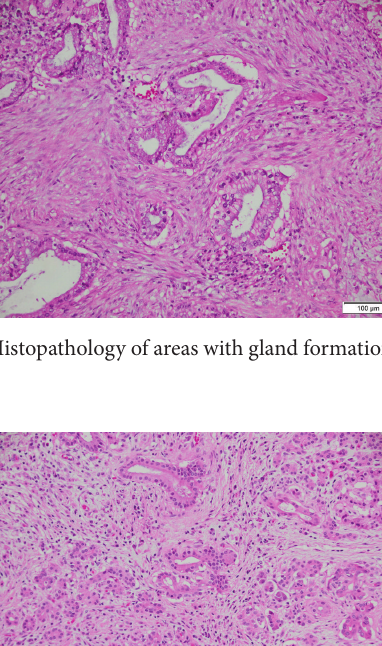
Figure 5: An irregular hypoechoic area within the head of the pan- creas above, which the common bile duct tapered.